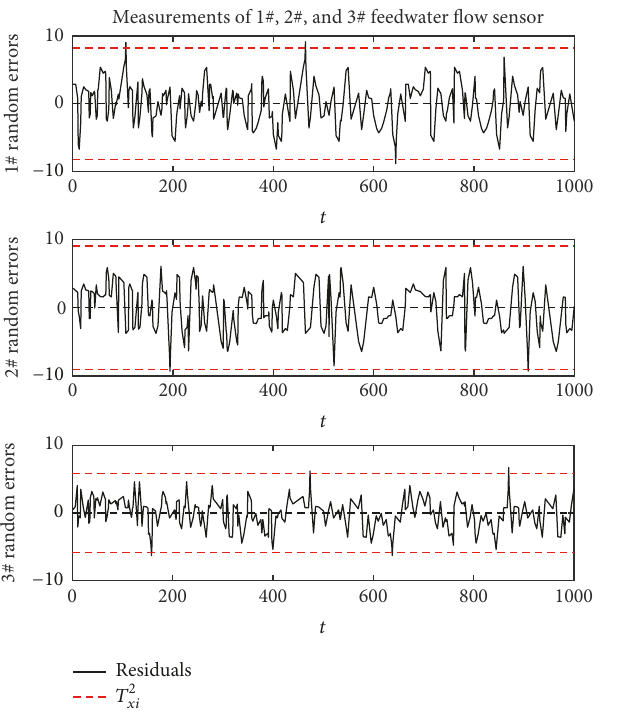
Figure 3: Measurements with and without singular points.